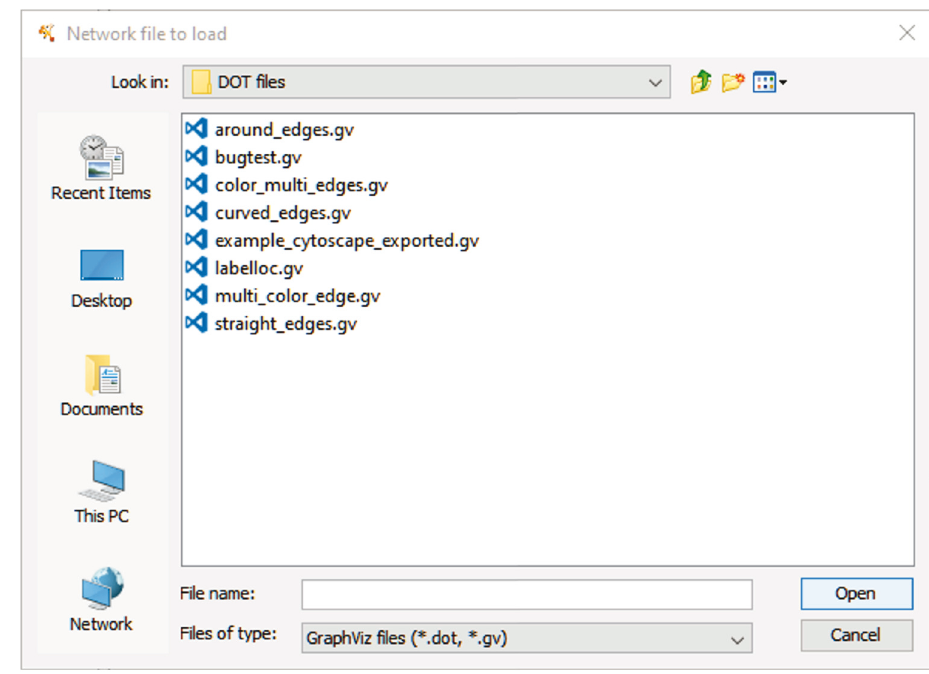
Figure 2. Network file to load dialog with Graphviz files